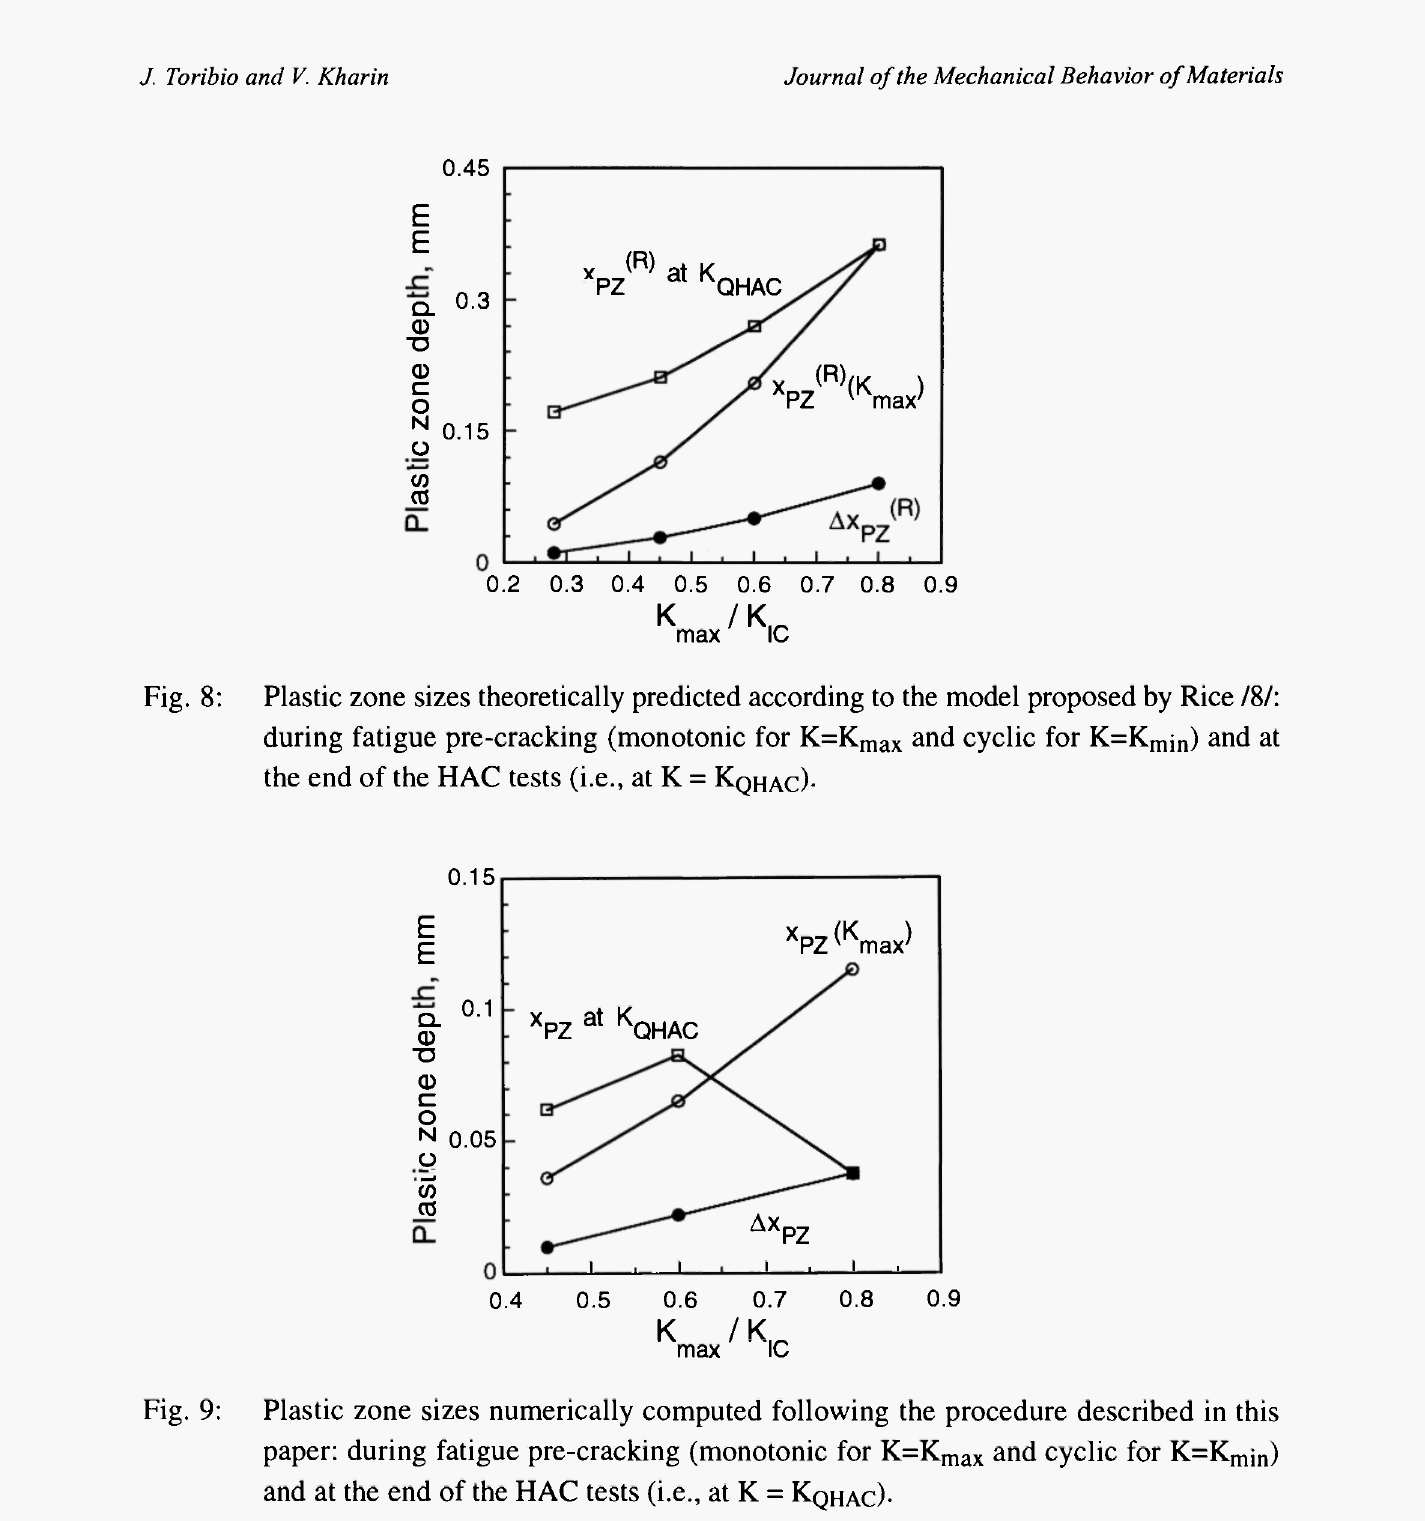
and cyclic for K=K j ) max m n